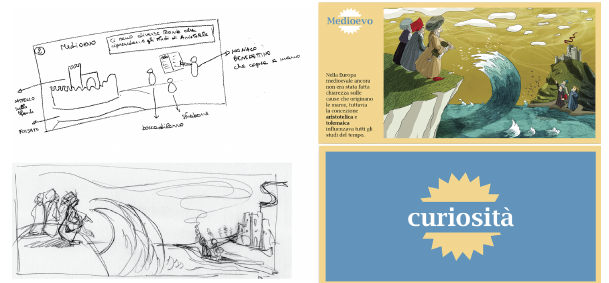
Figure 8. Different stages of making a curiosity card. The first draft, at the top left, is that of the researcher who tries to convey to the illustrator their idea of graphics (the graphic storyboard). The others are the different proposals and evolutions made by the illus- trator (illustration made by Francesca di Laura from INGV Labora- torio di Grafica e Immagine, graphic office).